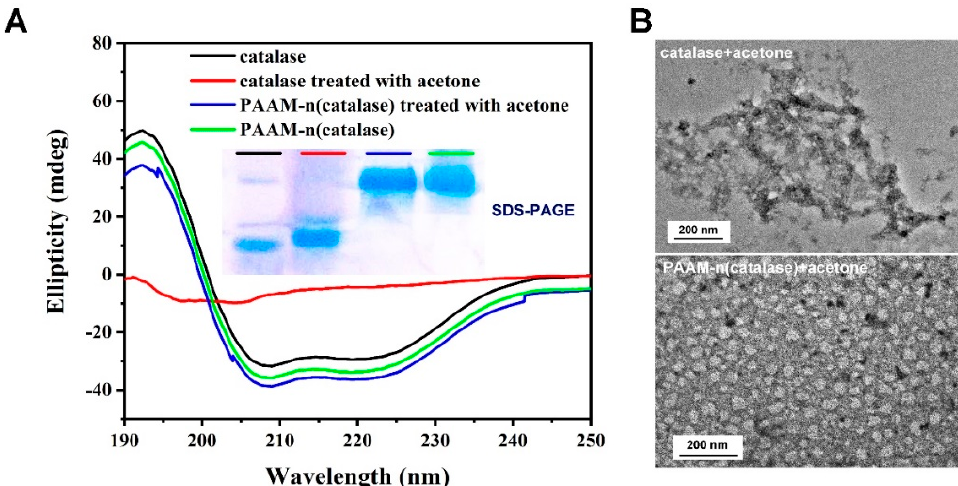
Figure 3. ( A ) Circular dichroism (CD) analysis of native catalase, PAAM-n(catalase), acetone-treated catalase and acetone-treated PAAM-n(catalase); the inset picture shows the SDS-PAGE analysis; ( B ) the representative TEM images of acetone-treated catalase and acetone-treated PAAM-n(catalase).